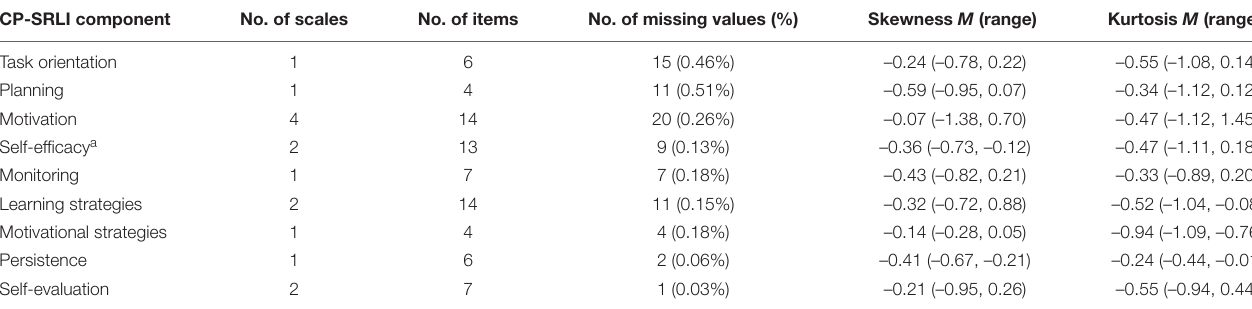
TABLE 1 | CP-SRLI components’ basic characteristics and shape of item distributions. CP-SRLI component No. of scales No. of items No. of missing values